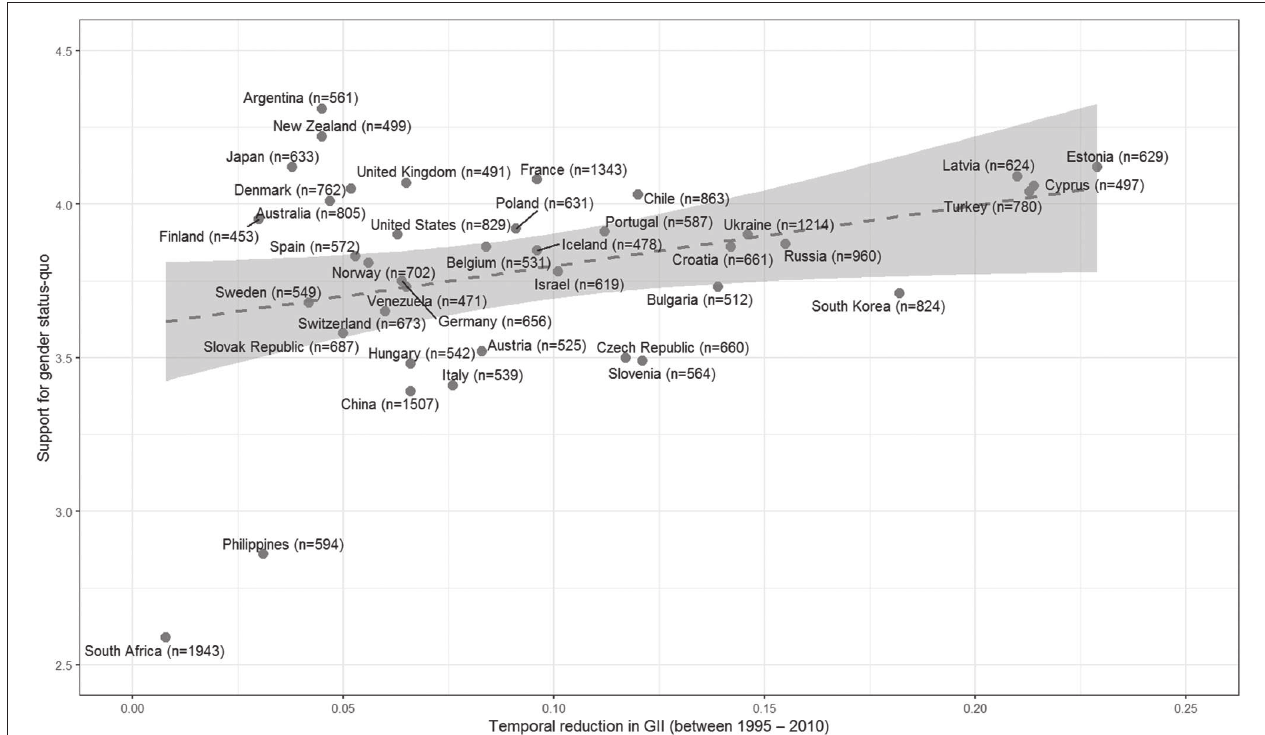
FIGURE 1 | Degree of reduction in gender inequality between 1995 and 2010 predicts tacit support for the gender status-quo in 2009 amongst 27,970 women in 39 nations, r = 0.33 ( N = 39, p = 0.04) (ISSP Research Group, 2017) (source: ISSP Research Group, 2017). Gender inequality index (GII; United Nations Development Programme, 2019) measures the inequality in achievement between women and men in three dimensions: reproductive health, empowerment and the labor market. Support for gender status-quo was measured with the item “Getting ahead: How important is being born a man or a woman?” (1 = essential, 5 = Not important at all); because accepting that gender does not matter in getting ahead represents satisfaction with the gender status-quo. This item is also conceptually similar to other items on the gender system justification measure [e.g., “everyone (male or female) has a fair shot and wealth and happiness”—Jost and Kay, 2005]. Gender is conceived here, not as a binary category, but as a multi- layered social stratification that includes men, women, and then transgendered people.